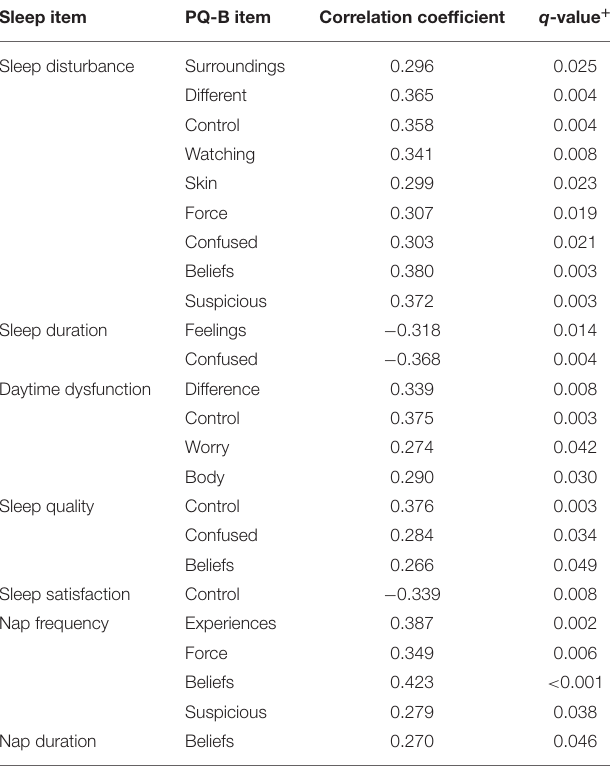
TABLE 5 | Significant correlations ( q < 0.05) between sleep variables and psychosis-risk symptoms measured on the PQ-B. Sleep